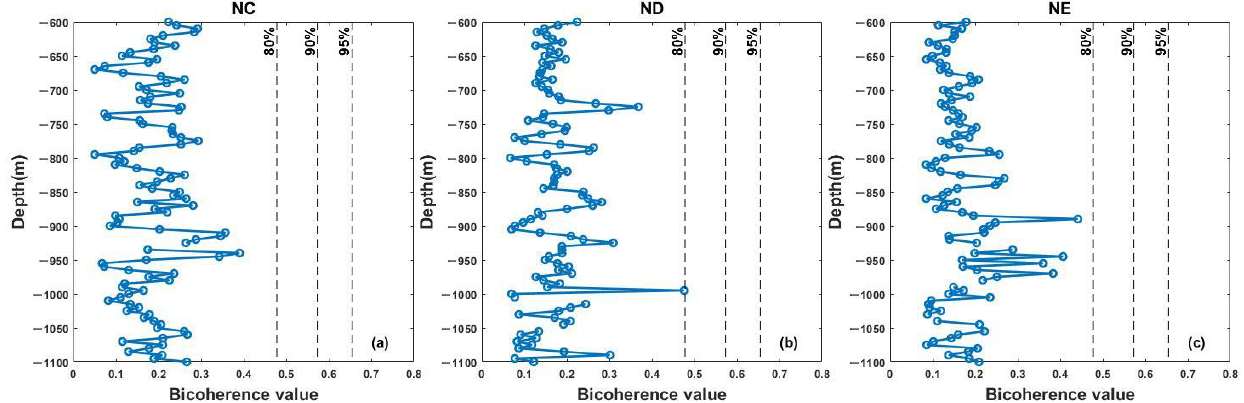
Figure 7. Bicoherence value in the frequency bin corresponding to PSI (FM2 = f + FM2 − f ) plotted as a function of depth. The vertical dashed lines give the 80%, 90%, and 95% significance levels. Figure ( a ) corresponds to the NC period, Figure ( b ) corresponds to the ND period, and Figure ( c ) corresponds to the NE period.